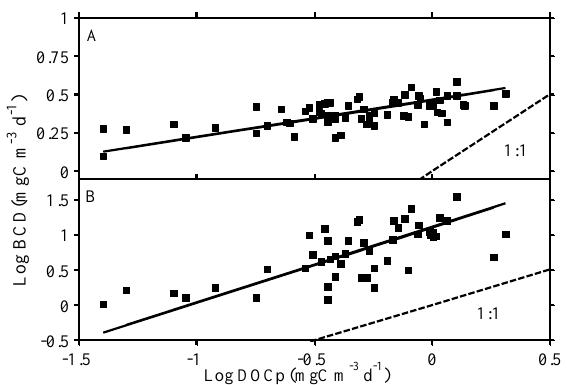
Figure 5. Relationship between DOCp and bacterial carbon demand (BCD). To compute BCD, bacterial growth efficiency was estimated with the models of (A) del Giorgio and Cole (1998) and Fig. 5. Relationship between DOCp and bacterial carbon de- (B) López-Urrutia and Morán (2007). See methods for details. mand (BCD). To compute BCD, bacterial growth efficiency was es- timated with the models of (A) del Giorgio and Cole (1998) and (B) L´opez-Urrutia and Mor´an (2007). See methods for